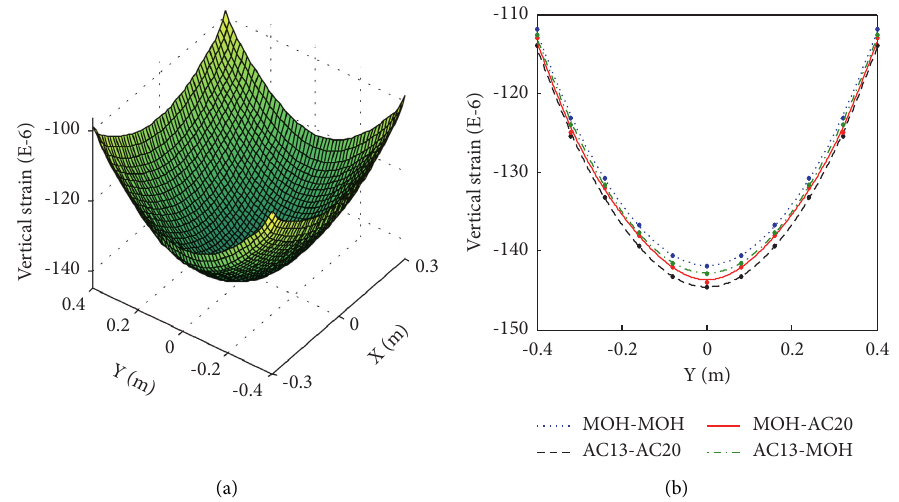
Figure 5: Vertical strain on top of the subgrade. (a) AC13-MOH. (b) X � 0.